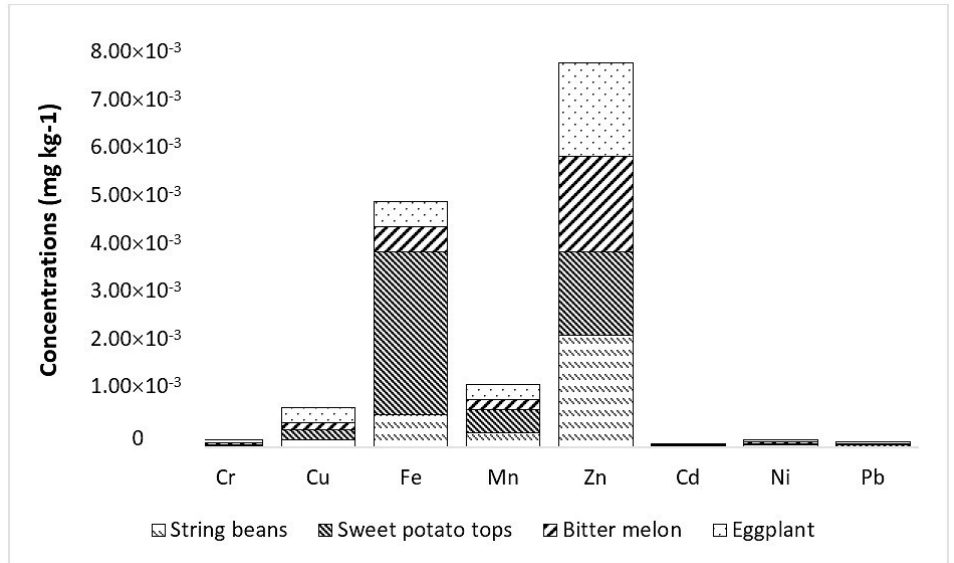
Figure 5. Contribution of vegetables to the average estimated daily intake (EDI) of metals.